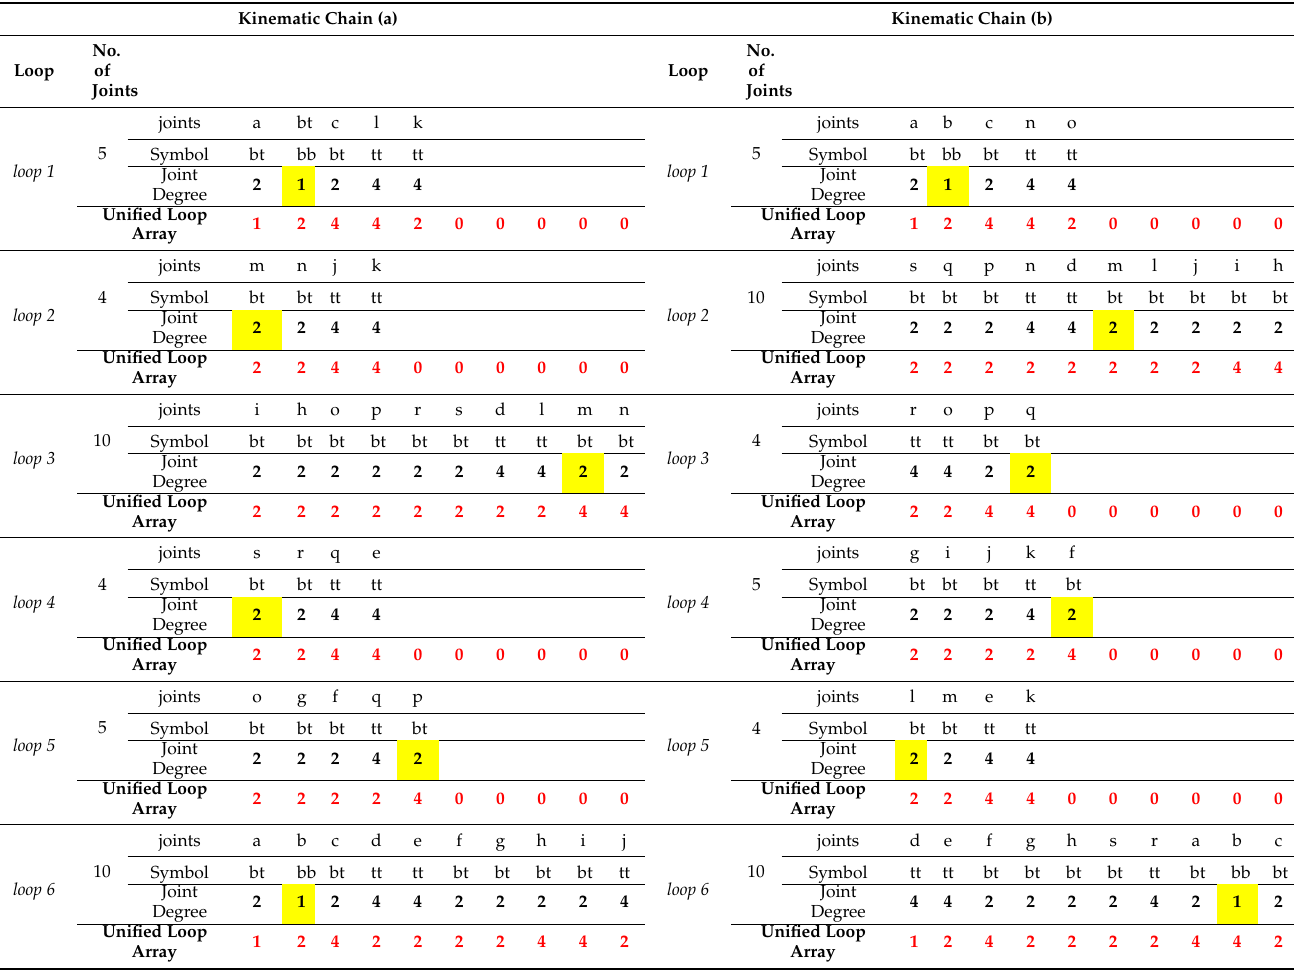
Table 10. Unified Loop Array for KCs in Figure